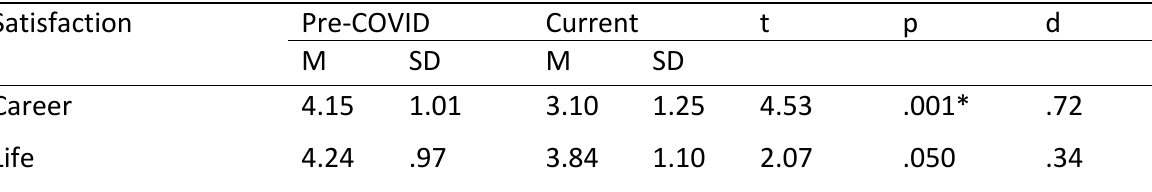
Satisfaction of South Carolina School-based Agricultural Education (SBAE) Teachers Prior to and During the COVID-19 Pandemic (n = 72)